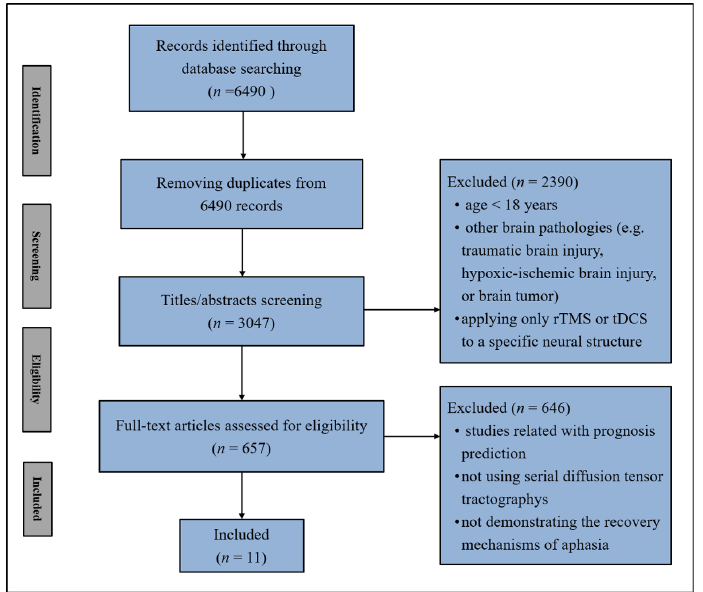
Figure 2. Flow diagram of the recovery mechanisms of aphasia study selection (rTMS: repetitive transcranial magnetic stimulation, tDCS: transcranial direct current stimulation). Table 2. Diffusion tensor tractography studies on the mechanisms of aphasia recovery in stroke.